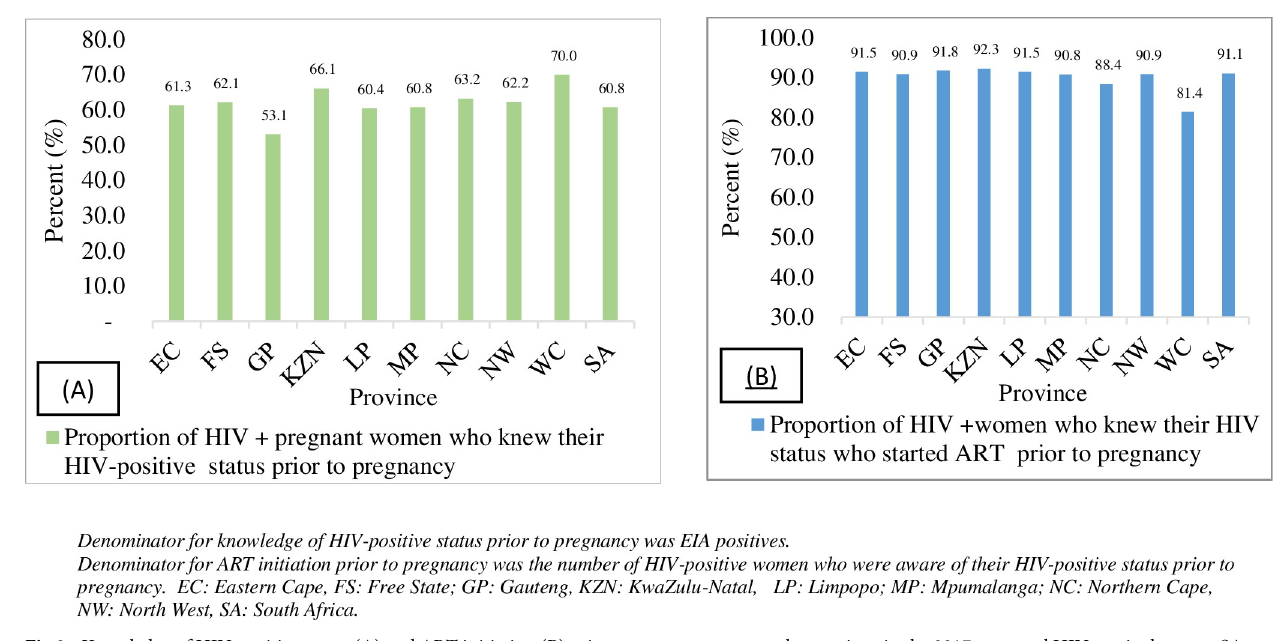
Fig 2. Knowledge of HIV-positive status (A) and ART initiation (B) prior to current pregnancy by province in the 2017 antenatal HIV sentinel survey, SA.